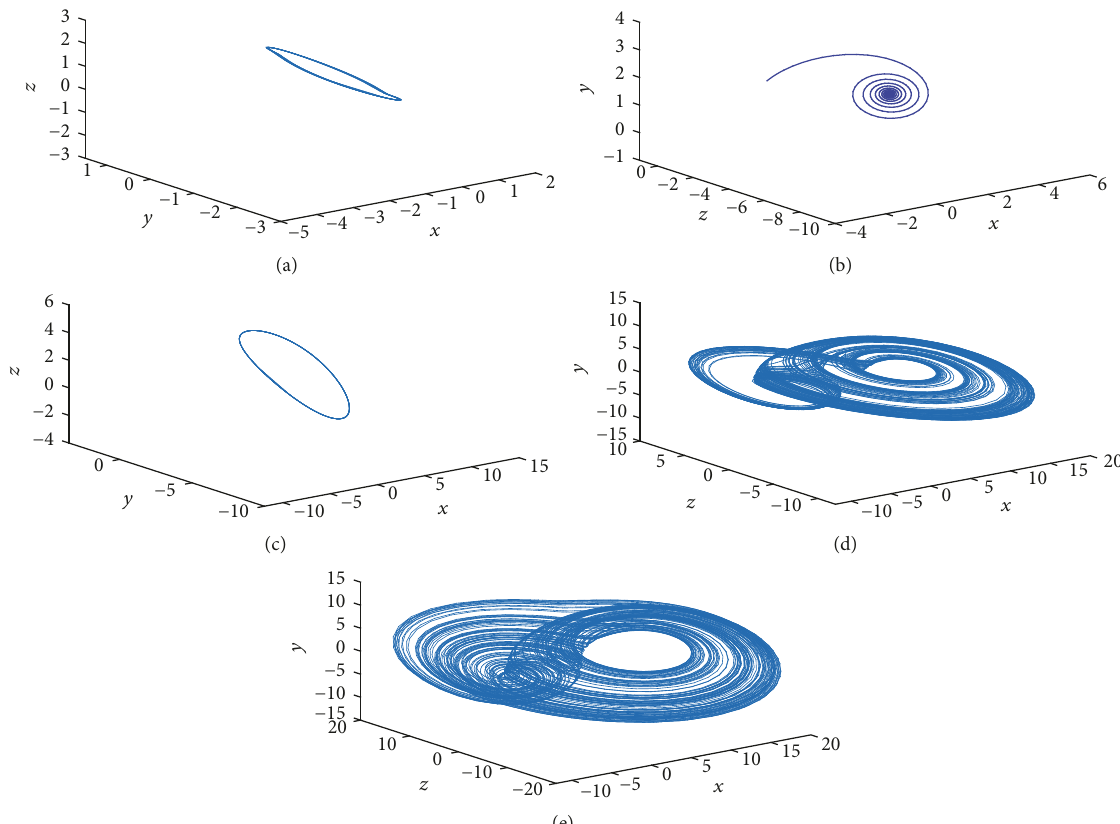
Figure 5: Different attractors forms exhibited by system (1) when parameter 𝑚 varies.